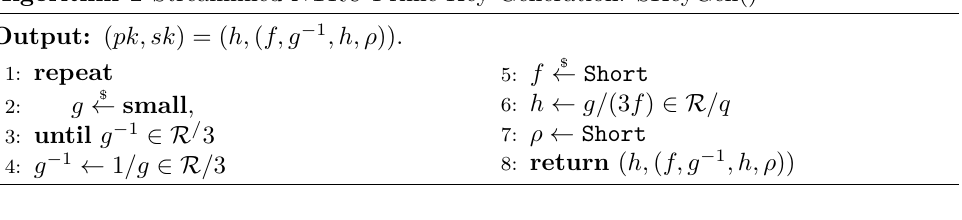
Algorithm 1 Streamlined NTRU Prime Key Generation: SKeyGen()